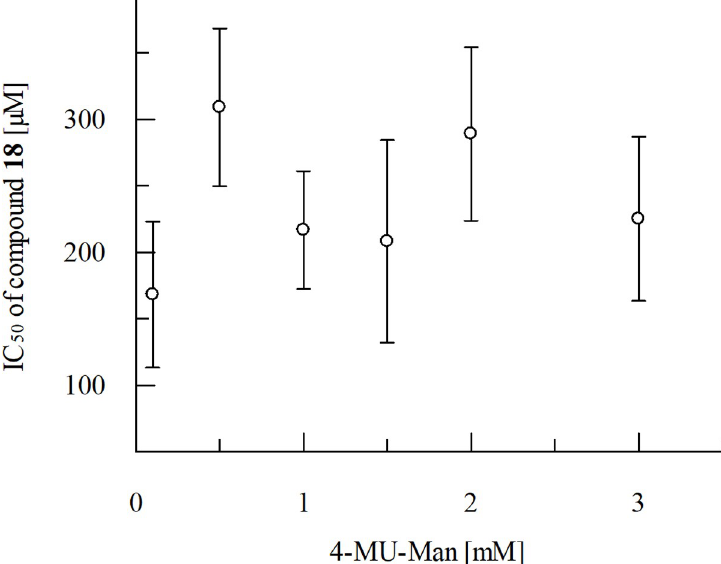
Fig 8. Effect of different substrate concentrations on the IC 50 values of compound 18 from three independent measurements. The single sample t-Test [45] was applied to calculate the significance of the results. The t -value is 1.01. The value of p is 0.37. The result is not significant at p > 0.05. The p-value indicates that there is no statistically significant difference in the IC 50 values of compound 18 at different substrate concentrations.